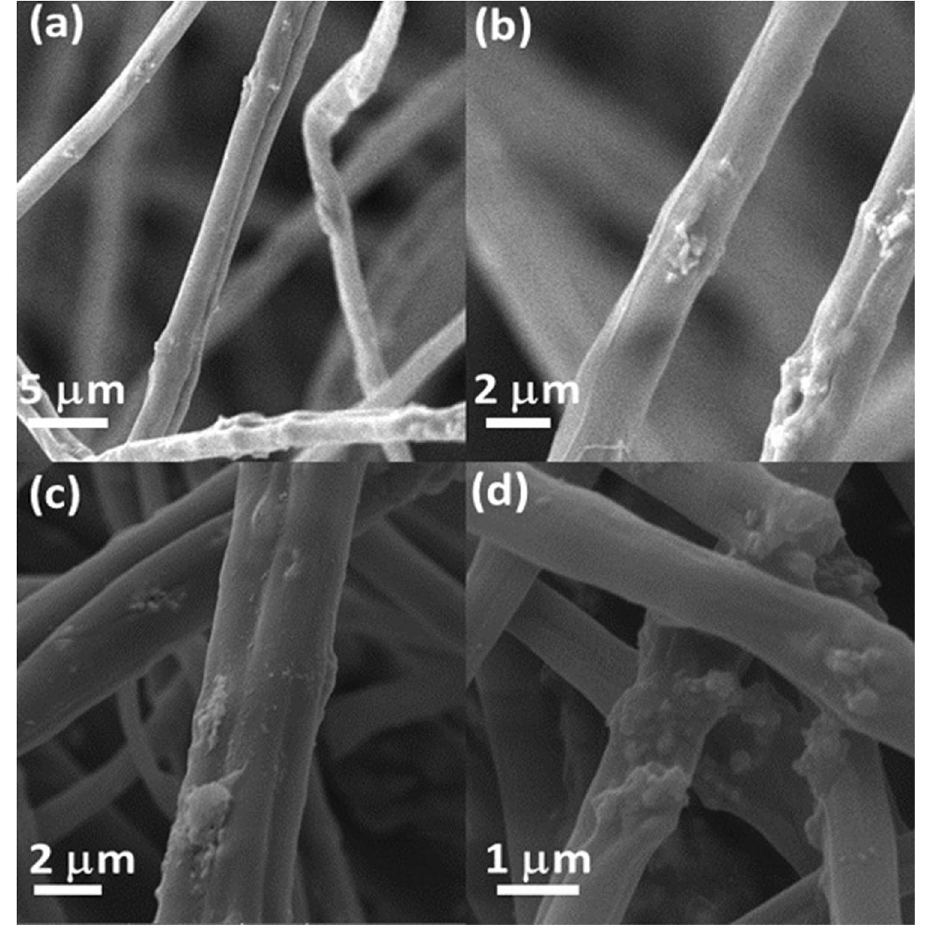
Figure 1. SEM images of electrospun CA fibers ( a ) and ( b ) with CA-ZnO fibers, ( c , d ) with CA-ZnO-Ag